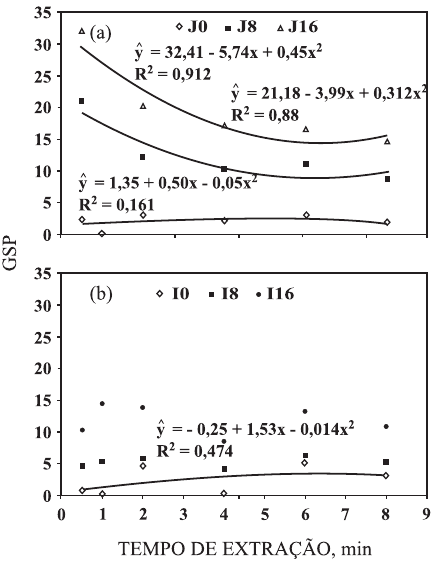
Figura 3. Extração pelo indicador ambiental GSP nos solos de Jaguariúna (a) e Itatinga (b), em função do tempo de extração e da dose de lodo aplicada ao